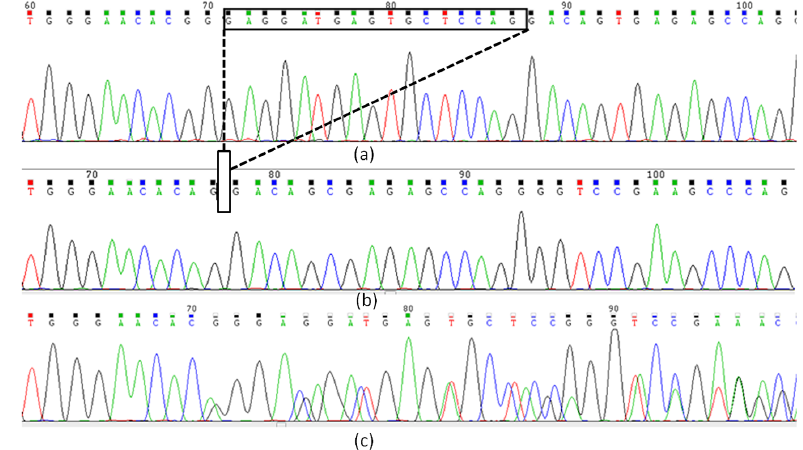
Figure 1. Sequencing maps for the 17 bp indel in the SMAD3 gene. Panel (a) : homozygotic insertion type (II); the sequence with the black border is 17 bp insertion. Panel (b) : homozygotic deletion type (DD). Panel (c) : heterozygote type (ID) Note: the location of the indel locus relates to GenBank No. NC_007308.5.